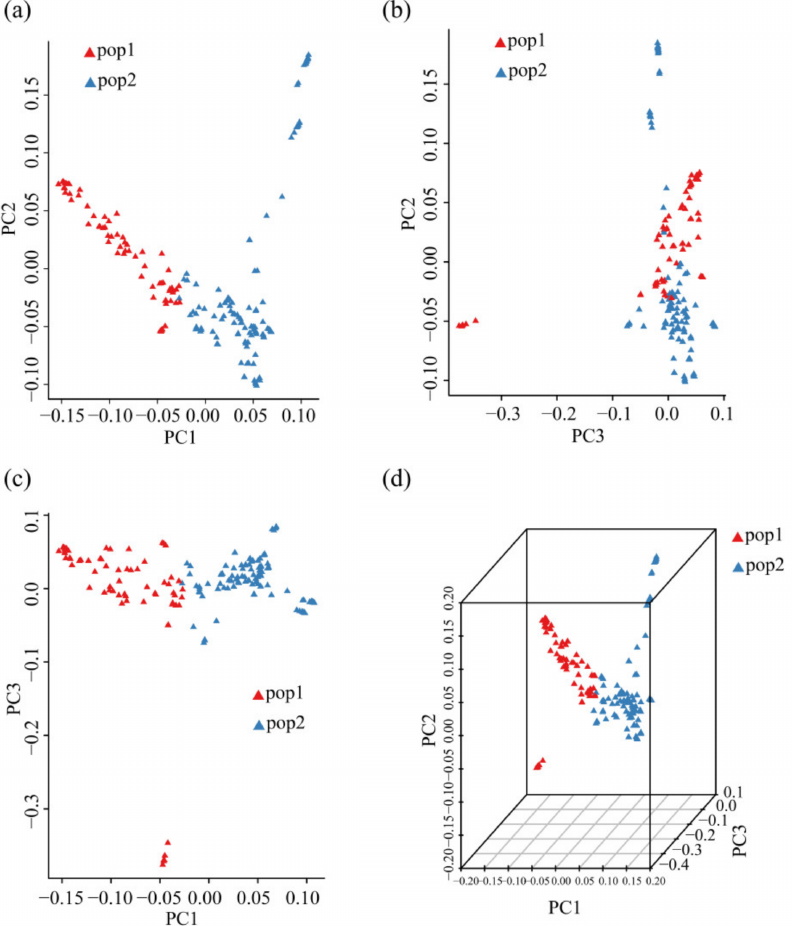
Figure 2. PCA of 185 Chinese chestnut landraces. ( a ) PC1 vs. PC2, ( b ) PC2 vs. PC3, ( c ) PC1 vs. PC3, ( d ) PC1 vs. PC2 vs.